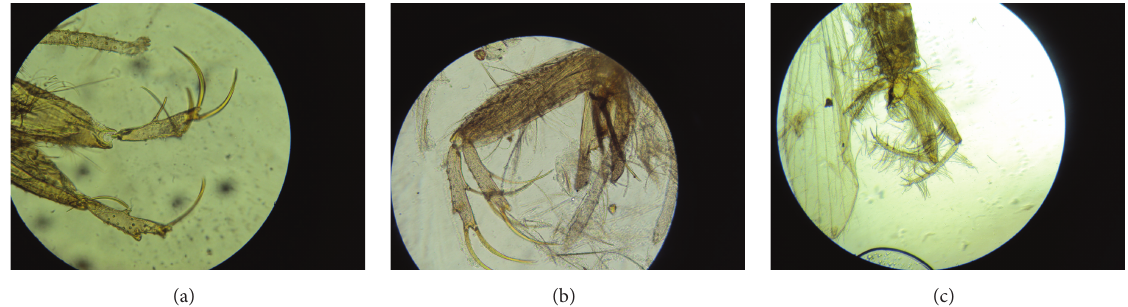
Figure 3: (a) Male genitalia and the extremity of penile valves in Phlebotomus , subgenus Larroussius ; (b) male genitalia and the extremity of penile valves in Phlebotomus perniciosus ; (c) male genitalia and the extremity of penile valves in Phlebotomus papatasi (personal photography; G × 40)